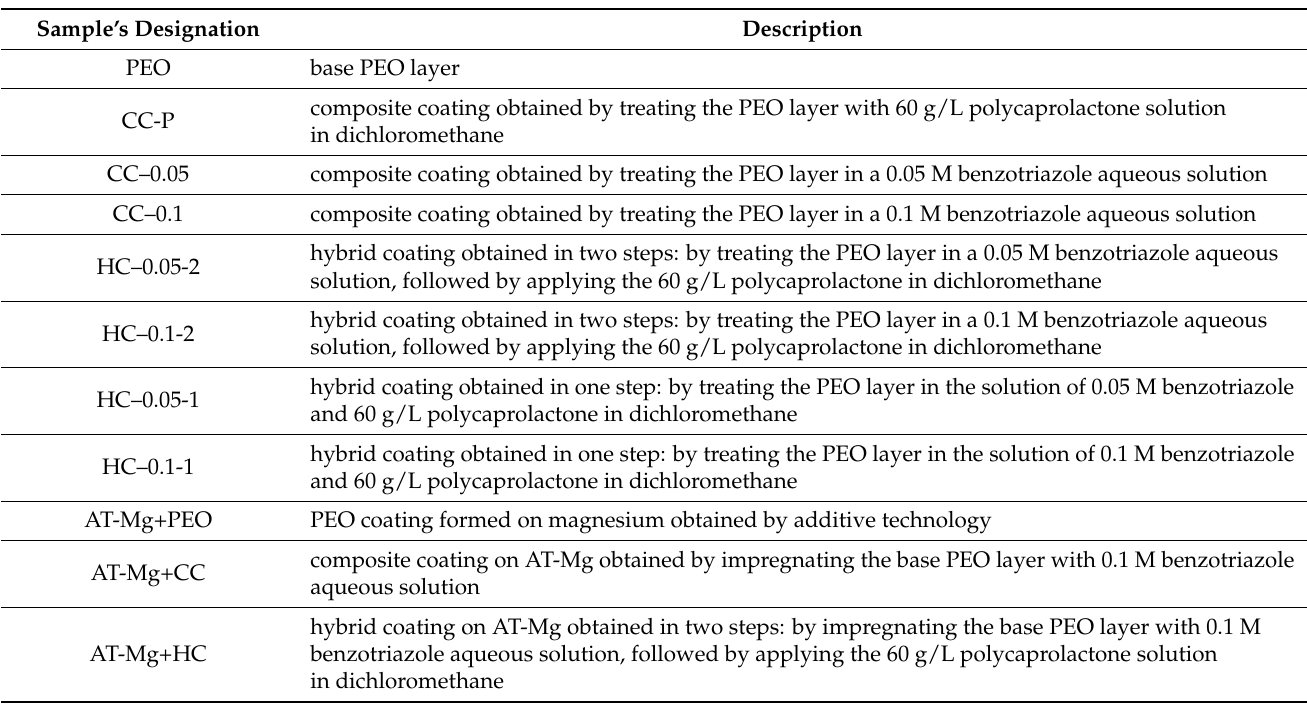
Table 1. Denominations of coatings formed during the presented study and their